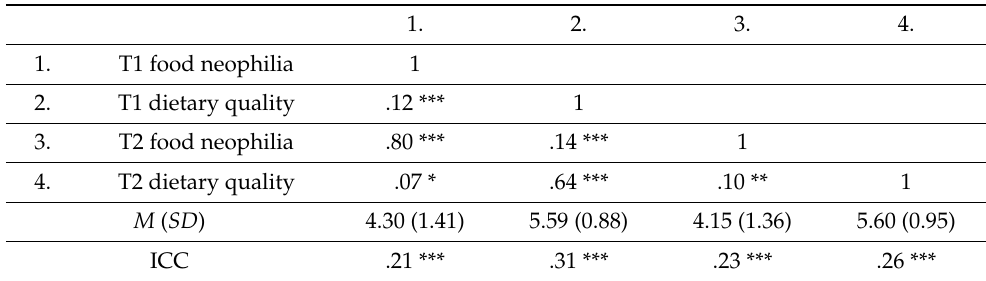
Table 2. Intercorrelations, descriptive statistics, and ICCs of manifest food neophilia and dietary quality at T1 and T2 ( N =